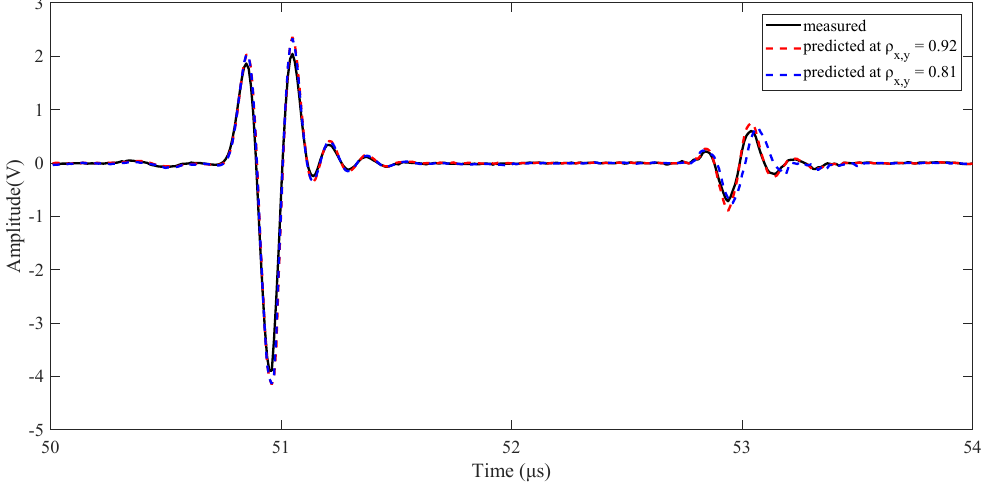
Figure 4. Waveform matches at different correlation coefficients.